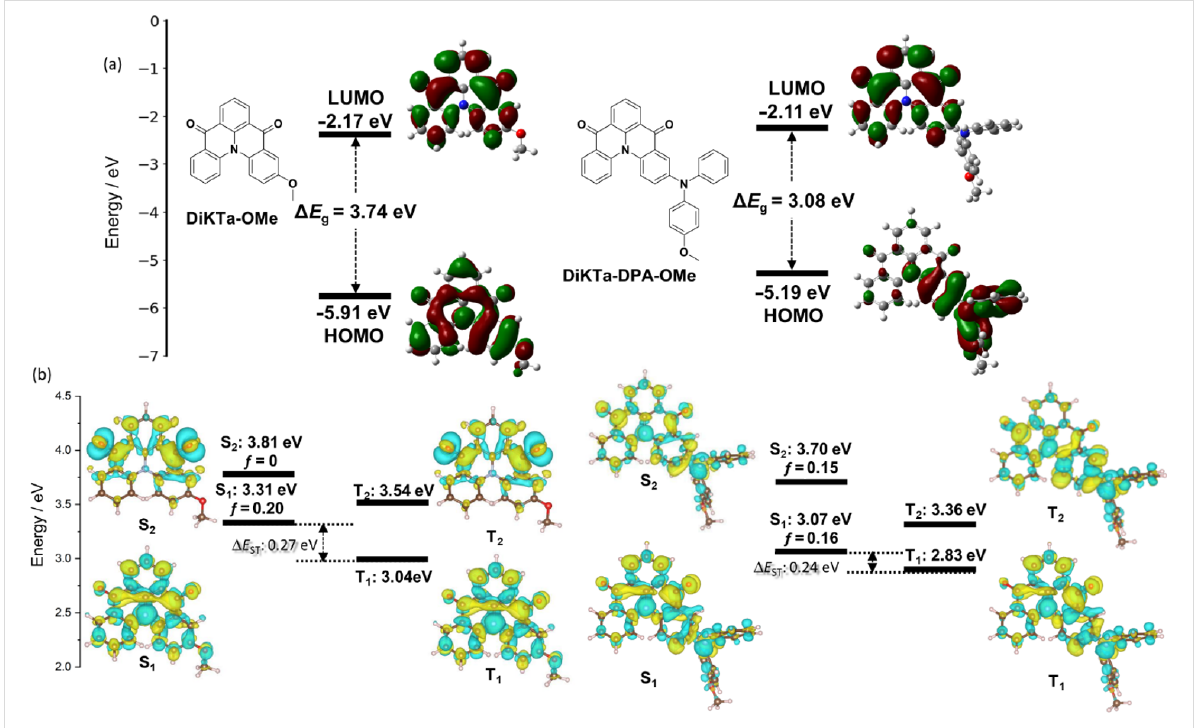
Figure 2: (a) HOMO and LUMO electron density distribution and orbital energies of DiKTa-OMe and DiKTa-DPA-OMe calculated at the PBE0/6- 31G(d,p) level of theory in the gas phase, isovalue = 0.02; (b) difference density plots and energies for the two lowest-lying singlet and triplet excited states for DiKTa-OMe and DiKTa-DPA-OMe calculated at SCS-CC2/cc-pVDZ in the gas phase (isovalue = 0.001). The blue color represents an area of decreased electron density, and yellow represents an increased electron density between the ground and excited states; f denotes the oscillator strength for the transition to the excited singlet